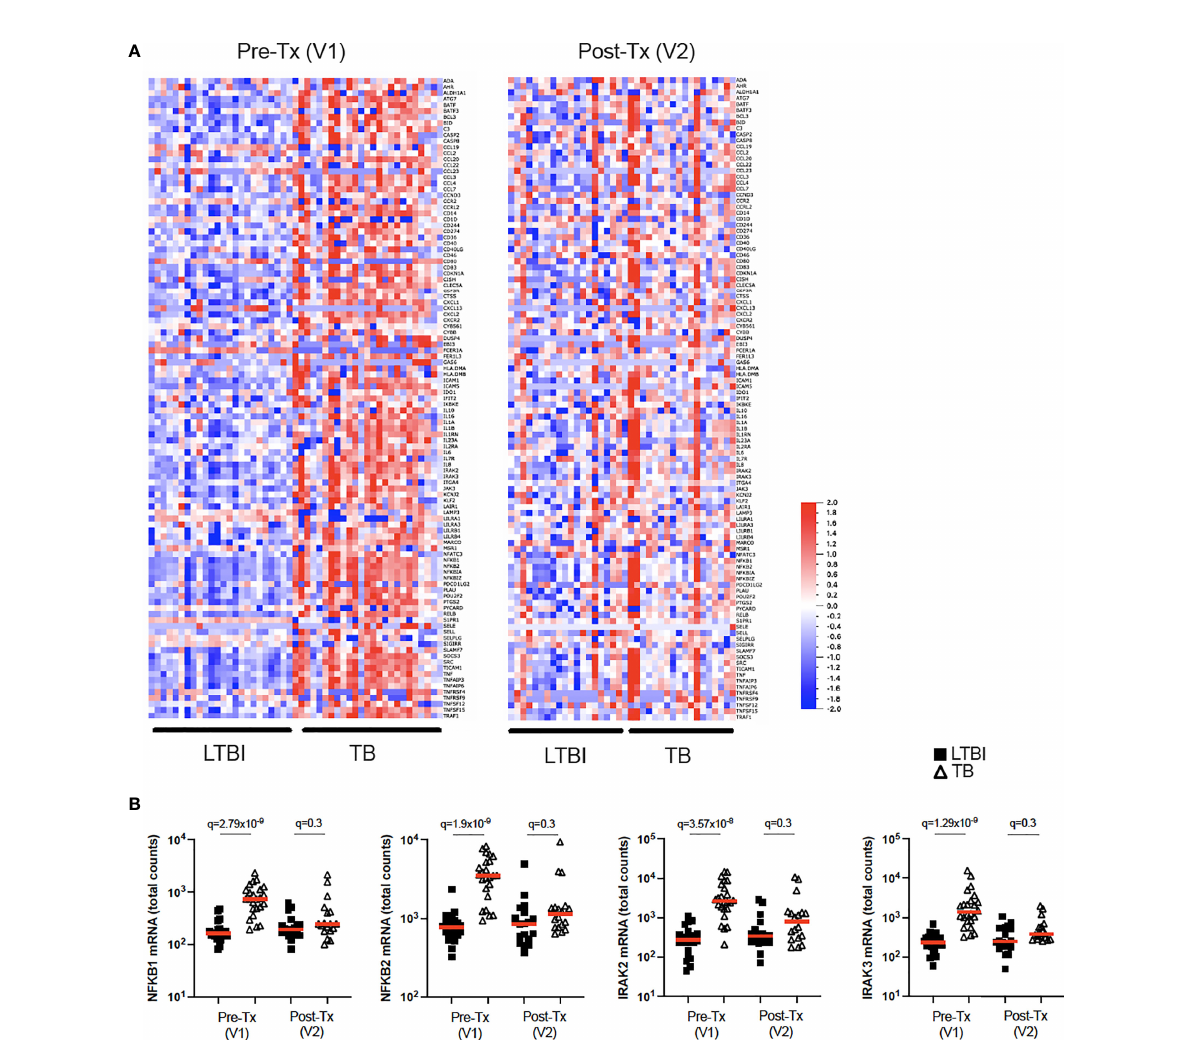
FIGURE 6 IL-1 b signalling is perturbed in active TB disease and is reset after successful antibiotic treatment. (A) Heatmap showing expression levels of IL- 1 b -induced genes (Null vs IL-1 b q=0.001) measured by Nanostring in LTBI and TB, in visit 1 pre-treatment (Pre-Tx V1) and visit 2 post-treatment (Post-Tx V2). (B) Levels of NFKB1, NFKB2, IRAK2 and IRAK3 mRNA measured by Nanostring after IL-1 b stimulation for LTBI and TB. Unpaired non-parametric t-test corrected for multiple comparisons. Red line: median values. Closed square: LTBI, Open triangle: TB. For panel (B) , q values (false discovery rate-adjusted p values) are